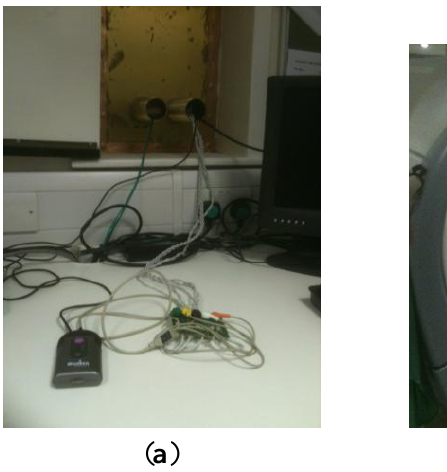
Figure 2. ( a ) The portable fetal and maternal ECG used for the study (AN24, Monica Healthcare, Nottingham, UK). The device records the data into internal memory over long periods but also transmits the maternal and fetal ECG data (four channels) in real time over a Bluetooth interface. The fECG monitor was connected to the six metre MR compatible high resistance leads which go through a waveguide into the scan room. The five leads were twisted as a pair and as a triplet. The trigger signal from the device was attenuated by 30 db and fed back into the scan room using a BNC cable (unfiltered in this case, although filtering could be used in future); ( b ) The leads attached to the MR compatible electrodes positioned on a torso phantom on a bed of conducting gel prior to location within the magnet for confirmatory safety